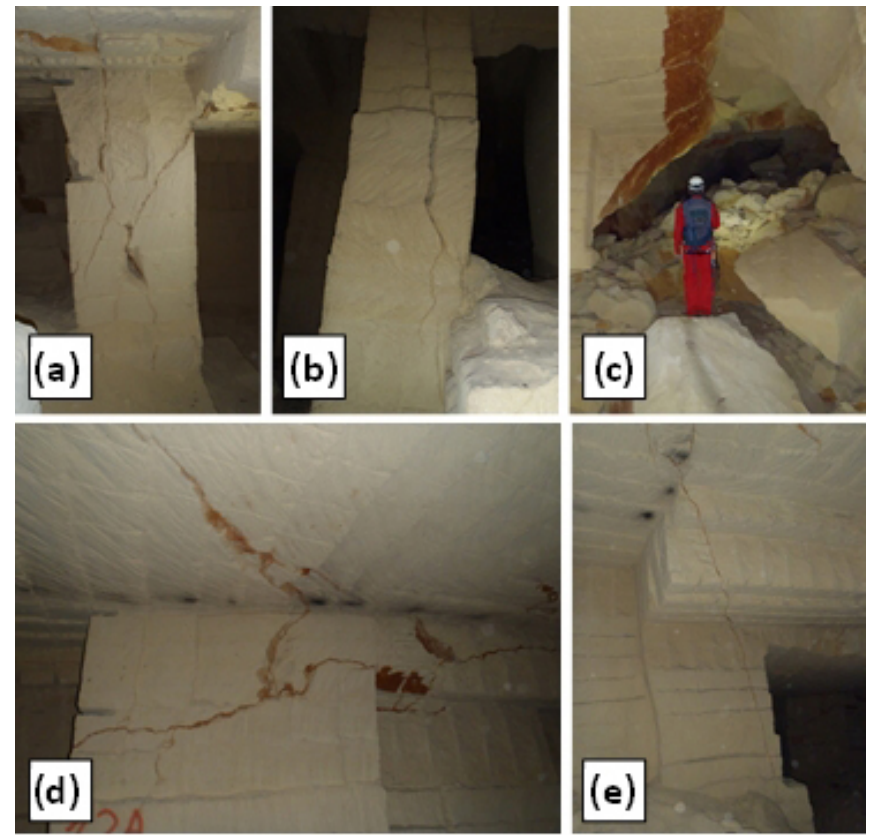
Figure 10. Instability evidence at the Marsala underground quarry: (a) fracturing of a pillar; (b) bending and failure of a pillar; (c) material detachments from the vault; (d, e) diffuse fracturing within the walls and the vaults (Bonamini et al., 2013).